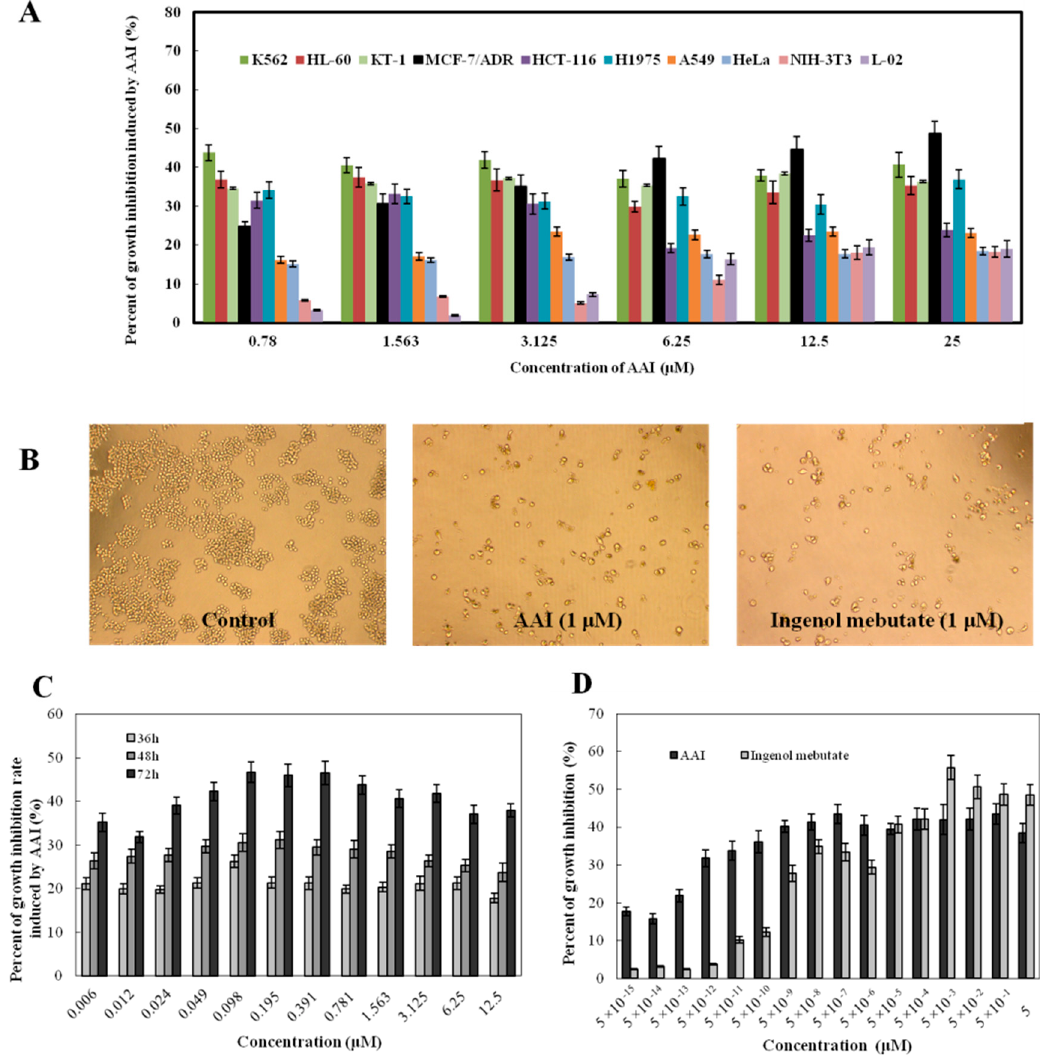
Figure 2. ( A ) Cytotoxicity of AAI assayed by 3-(4,5-dimethyl-2-thiazolyl)-2,5-diphenyl-2- H - tetrazolium bromide (MTT) methods. Tested cells in 96-well plates were treated with (0–25 μ M) AAI for 72 h, and then the viability was evaluated by MTT assay, as described in the Materials and Methods section; ( B ) AAI decreases the population of K562 cells in a comparable potency of ingenol mebutate. Cells in 96-well plates were treated with 1 μ M AAI or ingenol mebutate for 72 h, and then the cell density was photographed (×200); ( C ) growth inhibition of AAI against K562 cells. Cells were treated with indicated concentrations of AAI for 36, 48, and 72 h, and then the viability was evaluated by MTT assay; and ( D ) AAI shows stronger growth inhibition than ingenol mebutate at low concentrations. Cells were treated with indicated concentrations of AAI or ingenol mebutate for 72 h, and then cell viability was evaluated by MTT assay.